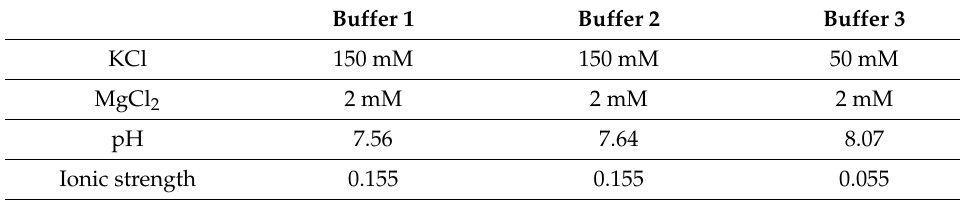
Table 2. Polymerization buffers.